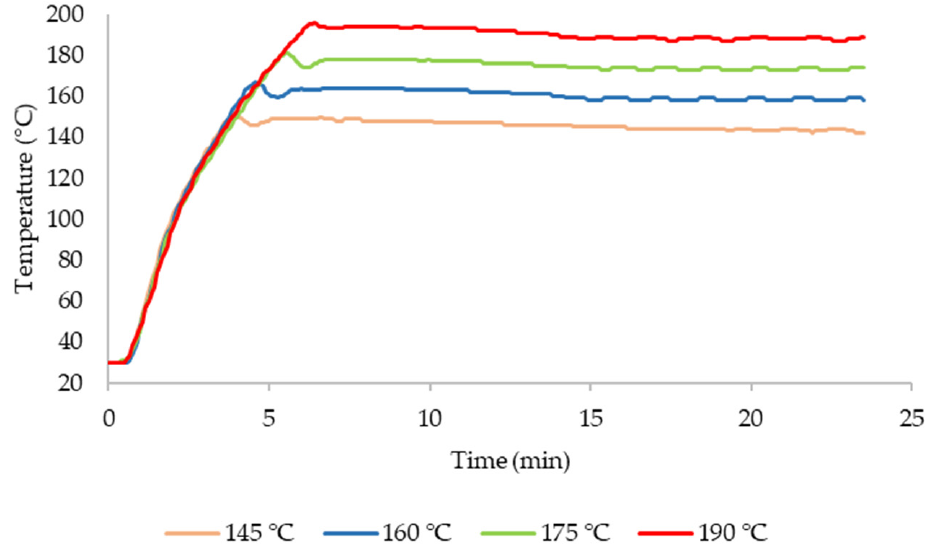
Figure 1. Temperature profiles corresponding to fractionation treatments performed in the microwave reactor.